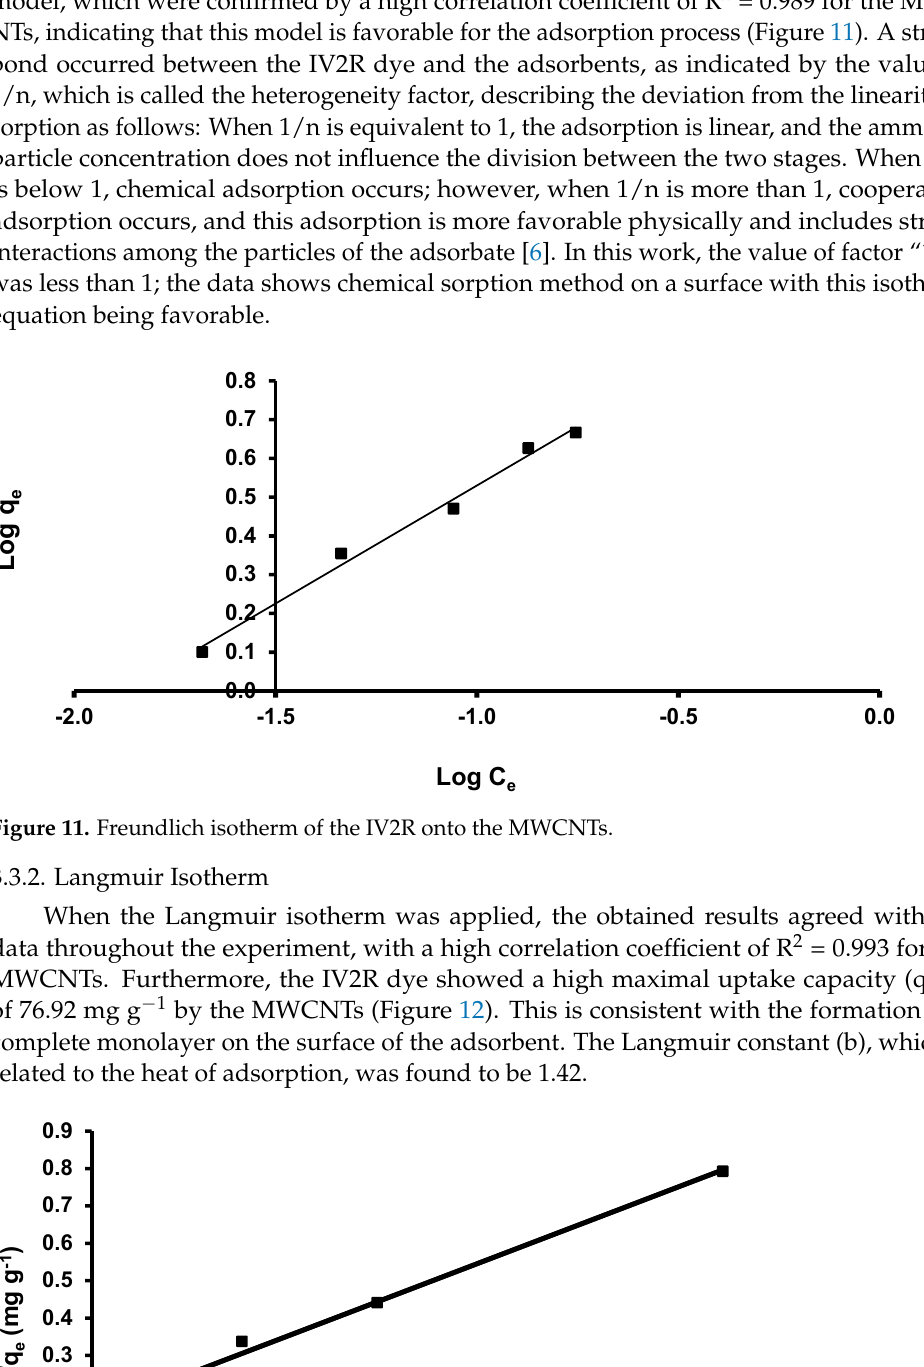
Figure 10. Influence of temperature on the removal of IV2R.